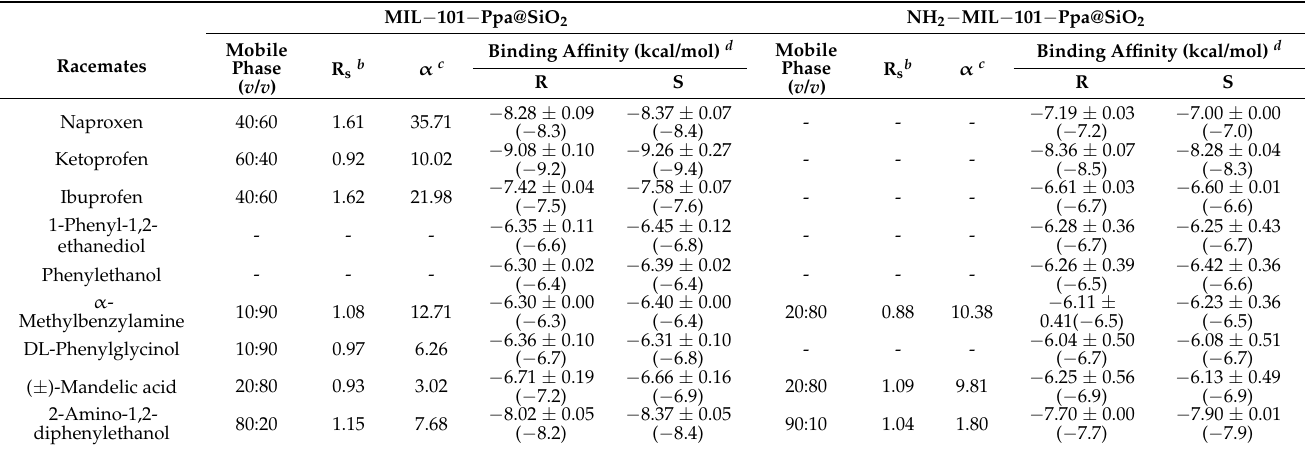
Table 1. HPLC separation of racemates on MIL − 101 − Ppa@SiO 2 and NH 2 − MIL − 101 − Ppa@SiO 2 columns with hexane/isopropanol as the mobile phase and molecular docking predictions a